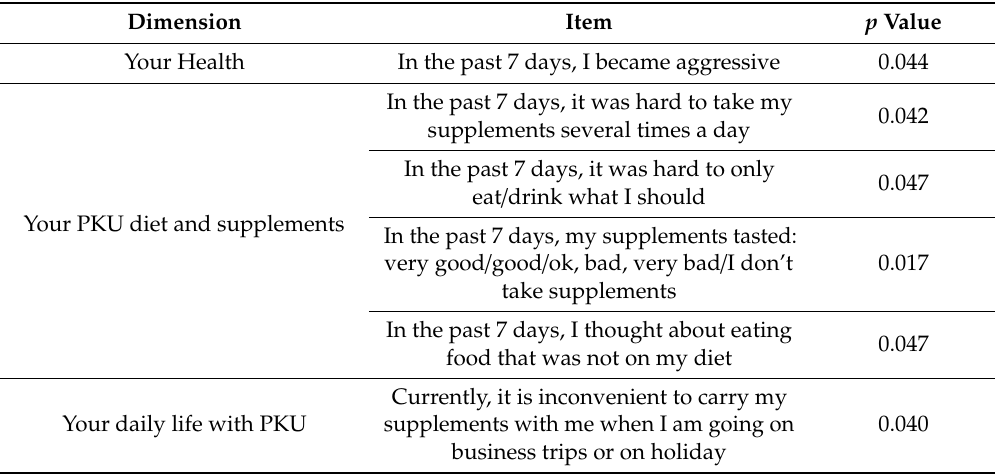
Table 4. Phenylketonuria-quality of life (PKU-QoL) score: data on specific dimensions and items after LNAA